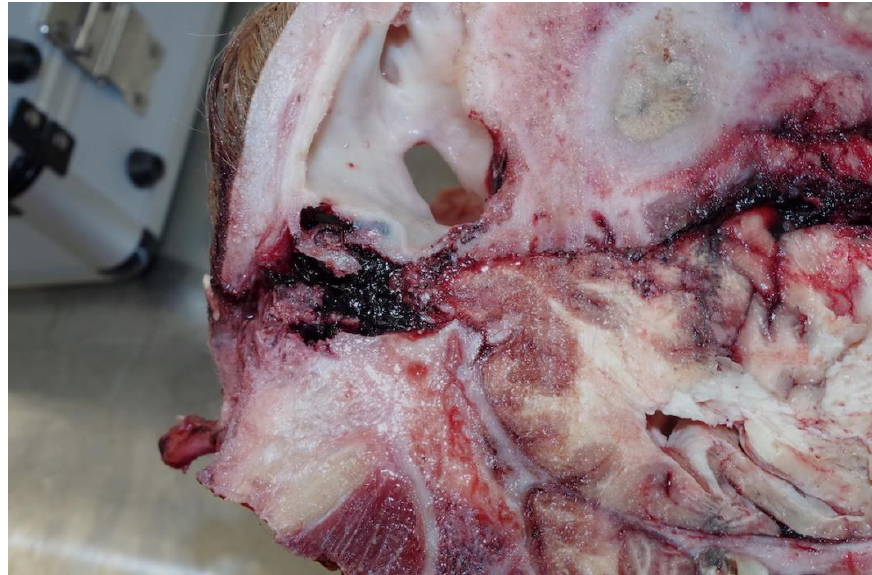
Figure 5. Shot 5 in poll position, left sagittal section.